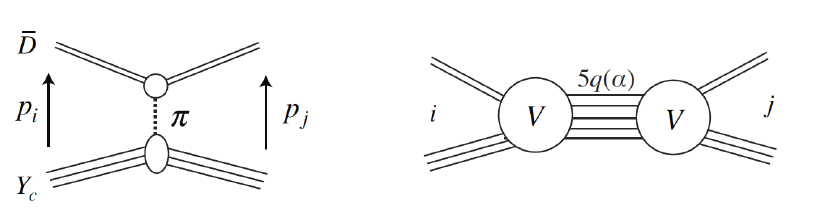
Figure 4. One pion exchange potential (left) and the e ff ective interaction due to the coupling to the five- quark channel (right). The meson-baryon channels are represented by D and Y c , i and j are, respectively, the initial and the final channels, while a five-quark channel is denoted by α . (APS copyright